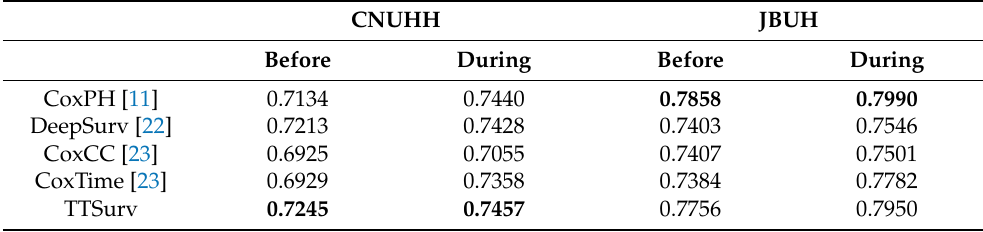
Table 3. Mean absolute error for overall survival prediction.